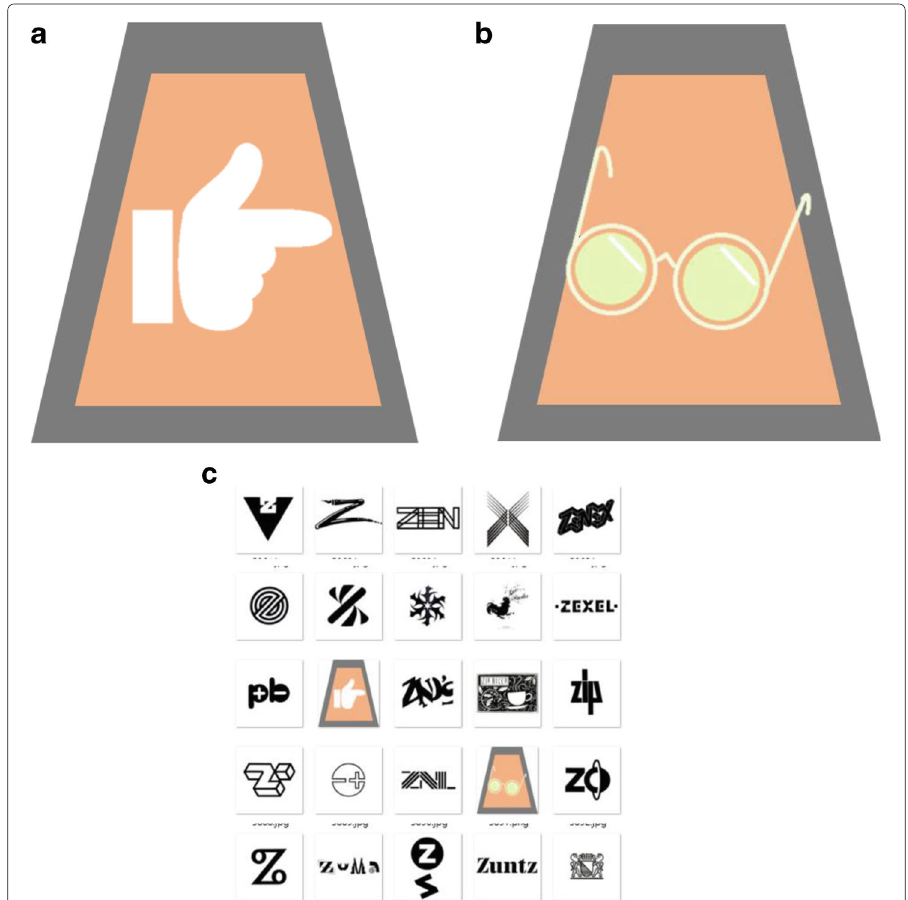
confusion in environmental